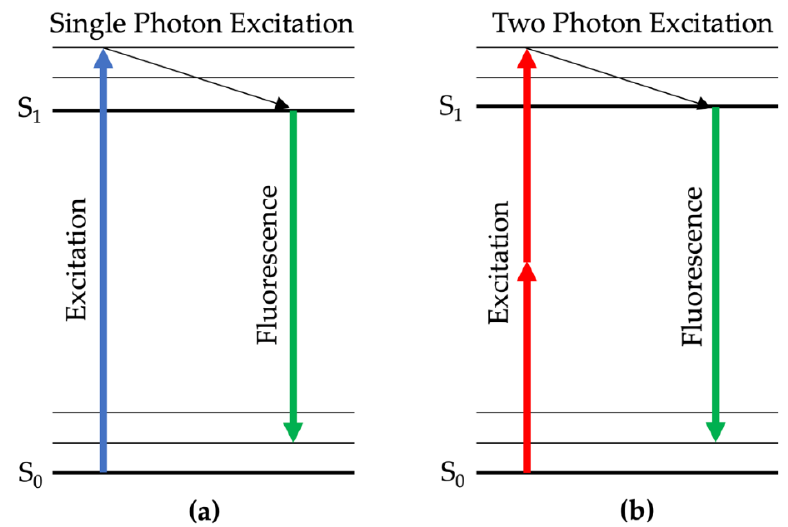
Figure 3. Jabłoński diagrams of single vs. two photon excitation principles: ( a ) In single photon excitation, the excitation wavelength is shorter than the fluorescence wavelengths; ( b ) in two photon excitation, the wavelengths of two exciting photons are longer then the resulting fluorescence. Multiphoton laser tomography (MPT) uses two near-infrared (NIR) photons to excite dermal fluorophores.